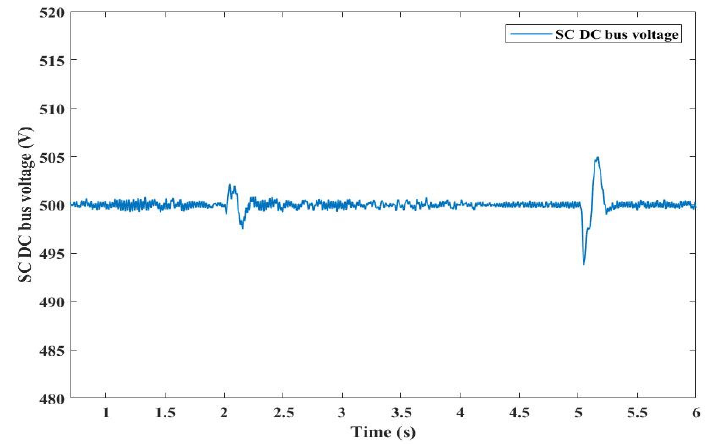
Figure 18. DC bus voltage at SC for PV power variations.